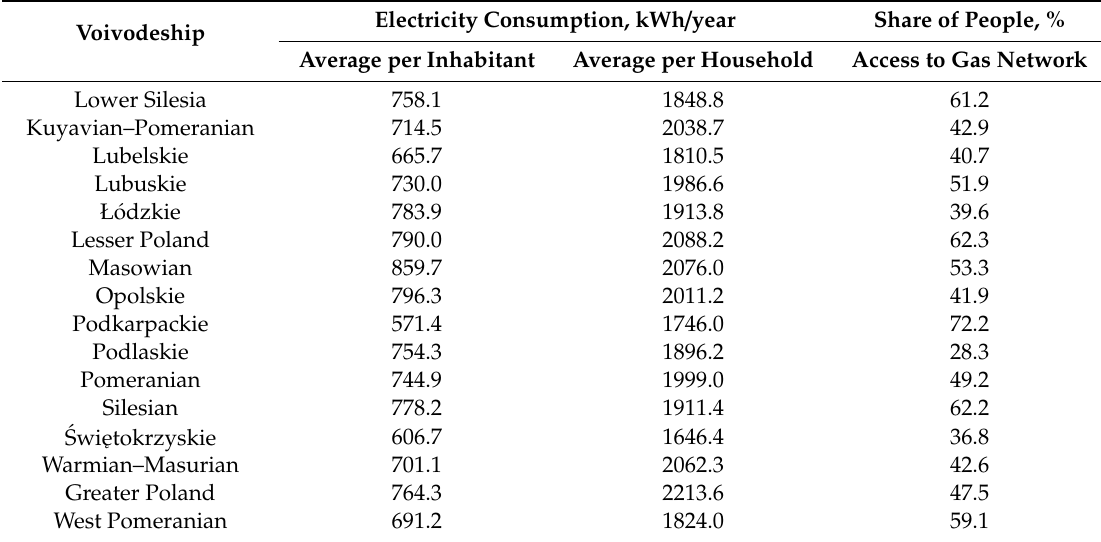
Table 3. Structure of average electricity consumption in households in individual voivodships and access to the gas network. Source: own study based on [69].